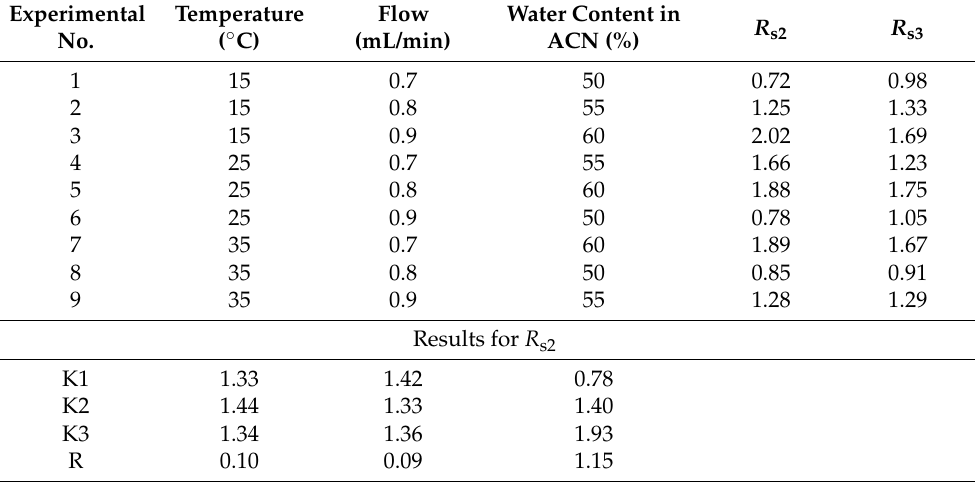
Table 2. L9 orthogonal array table used for method optimization, with the obtained critical resolu- tion values.